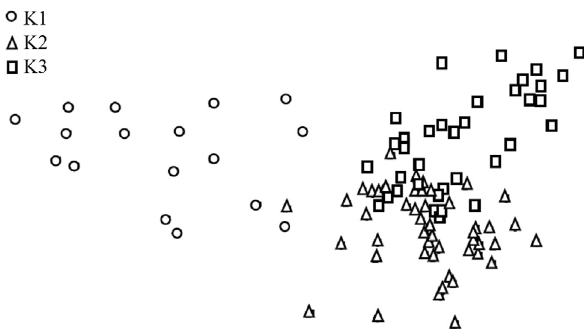
Figure 2 - Orthogonal projection of the cloud of points representing the geneticdistanceamongcultivars,basedon38unlinkedmolecularmarkers analyzed by multiple correspondence analysis. Subpopulations K1-K3 were inferred using Structure